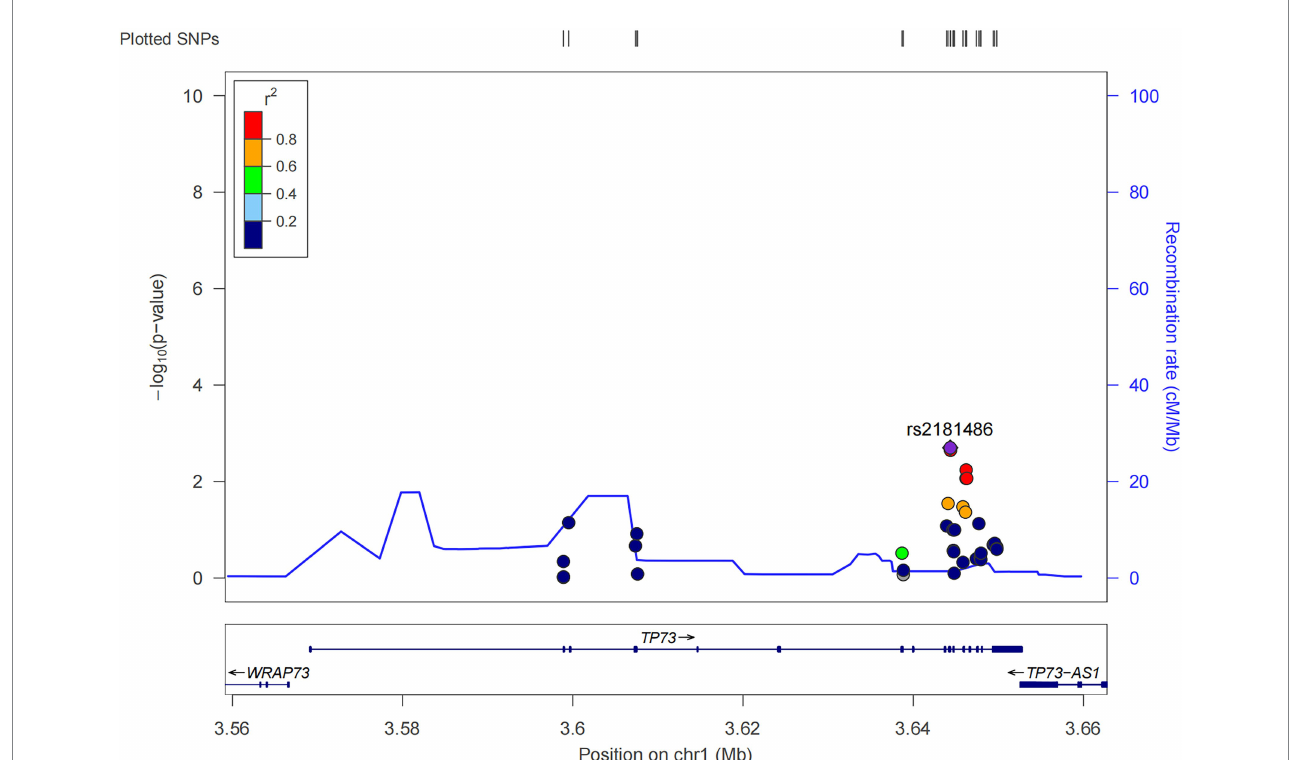
FIGURE 2 Locuszoom of the 36 common TP73 variants identified in this study